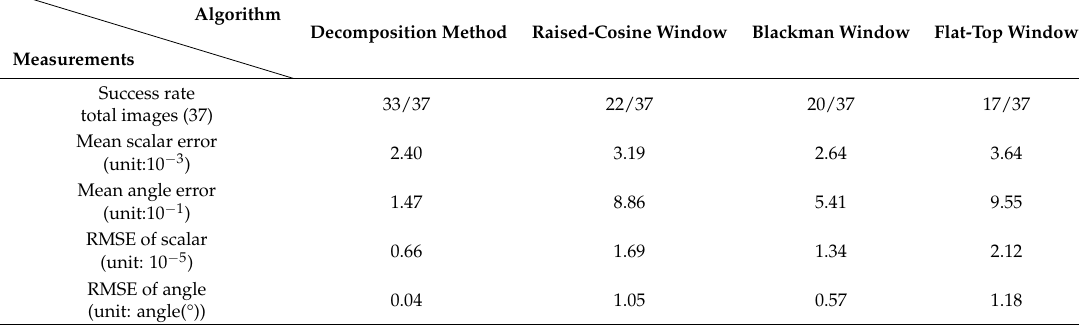
Table 2. Comparison of the performance of each algorithm in estimating scalar and angles.